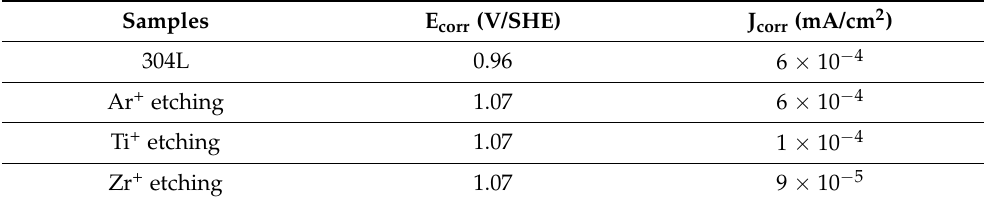
Table 2. Corrosion potential (E corr ) and current density (J corr ) values after 48 h of immersion in a nitric acid solution at boiling